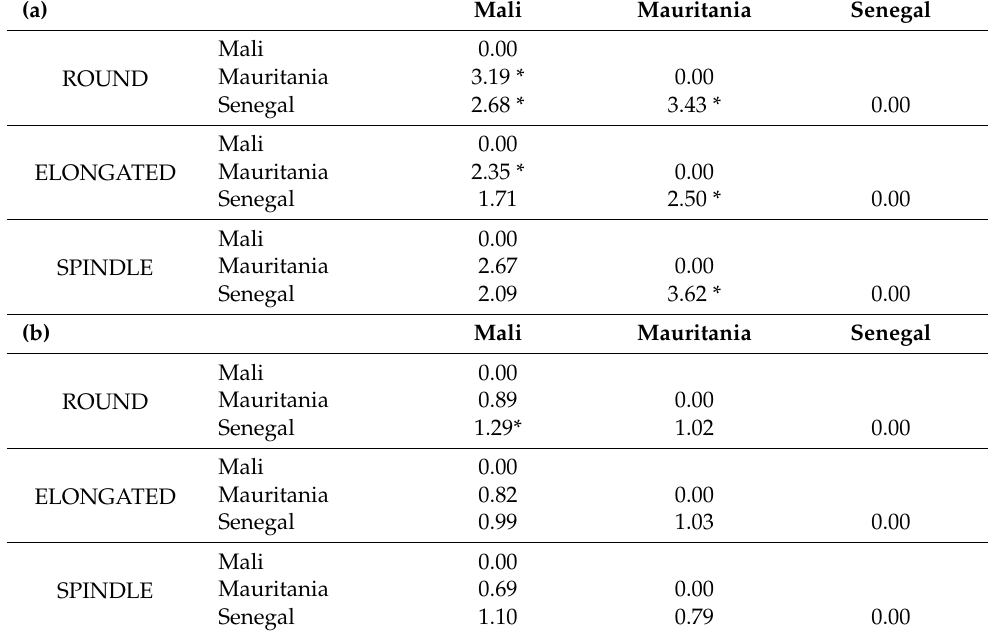
Table 7. Mahalanobis distances between the nine S. haematobium egg populations according to their morphotype (round, elongated and spindle) and geographical origin (Mali, Mauritania and Senegal) for the discriminant analysis performed: ( a ) all measurements analyzed and ( b ) spine measurements